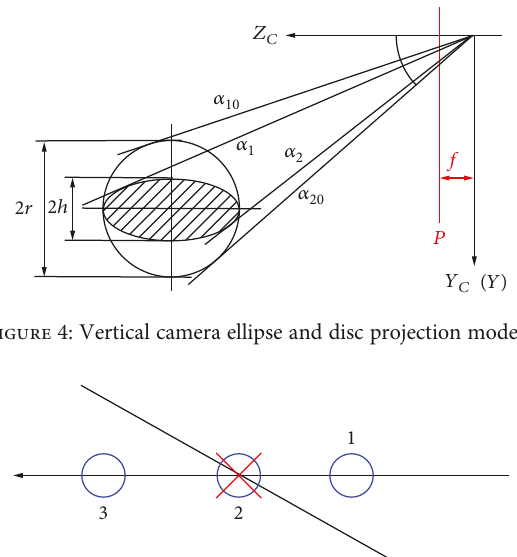
Figure 3: Oblique camera disc projection model.